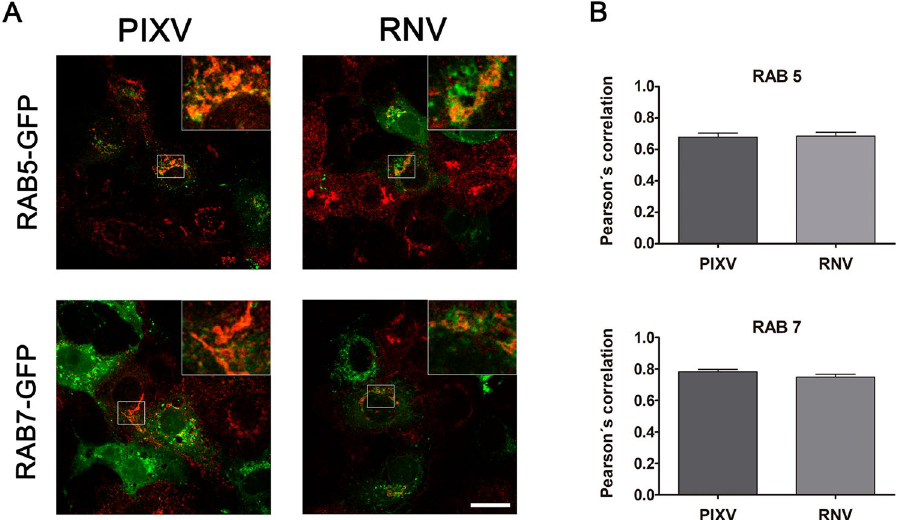
Figure 3. Colocalization of PIXV and RNV with Rab5 and Rab7. ( A ) Immunofluorescence of transiently transfected cells with plasmids expressing Rab5-GFP or Rab7-GFP (green) and infected with PIXV or RNV (red) at MOI 10. ( B ) Colocalization analyses for Rab5-GFP or Rab7-GFP expression with PIXV or RNV were expressed as Pearson’s correlation coefficient. The plots show the mean of Pearson’s correlation coefficients ± SD, n = 10–12 cells for each condition from three independent experiments. Scale bar: 20